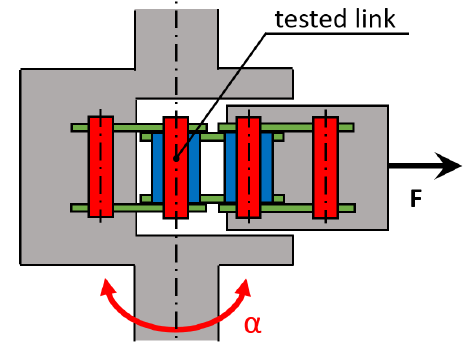
Figure 6. Schematic setup of chain joint